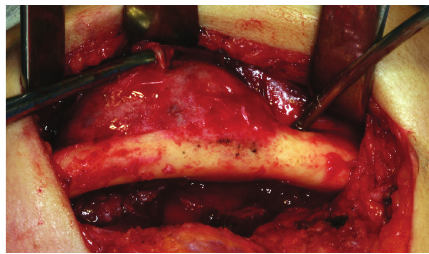
Figure 3: Transoperative view of the tumor.